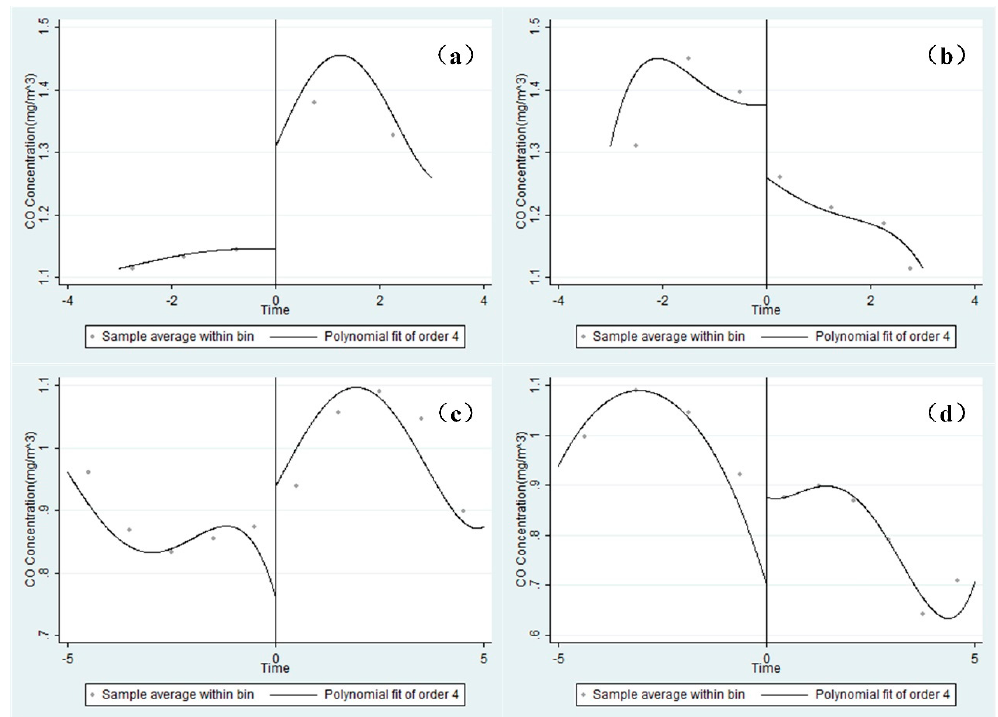
Figure 4. The results of the RD of CO concentration in restriction period in Policies 2 and 3: ( a ) 4:00 p.m. in Policy 2; ( b ) 7:00 p.m. in Policy 2; ( c ) 3:00 p.m. in Policy 3; and ( d ) 8:00 p.m. in Policy 3.